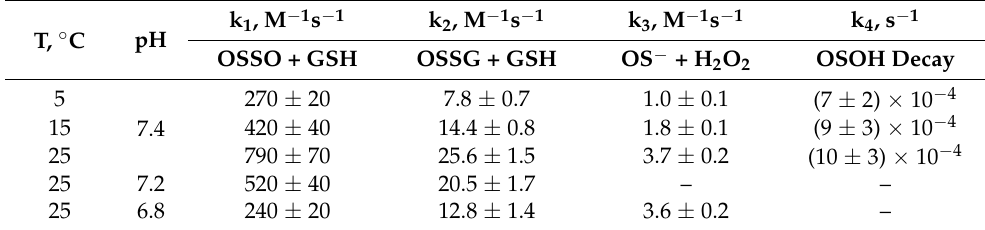
Table 1. Rate constants of the reactions of OSSO reduction and OSH oxidation.